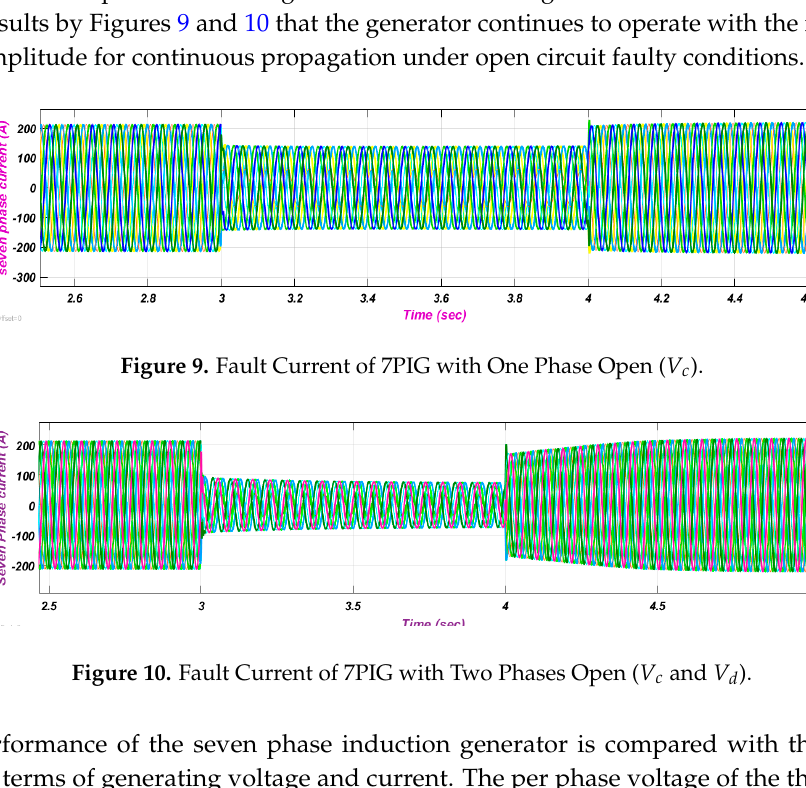
Figure 10. Fault Current of 7 P IG with Two Phases Open ( V c and V d ).